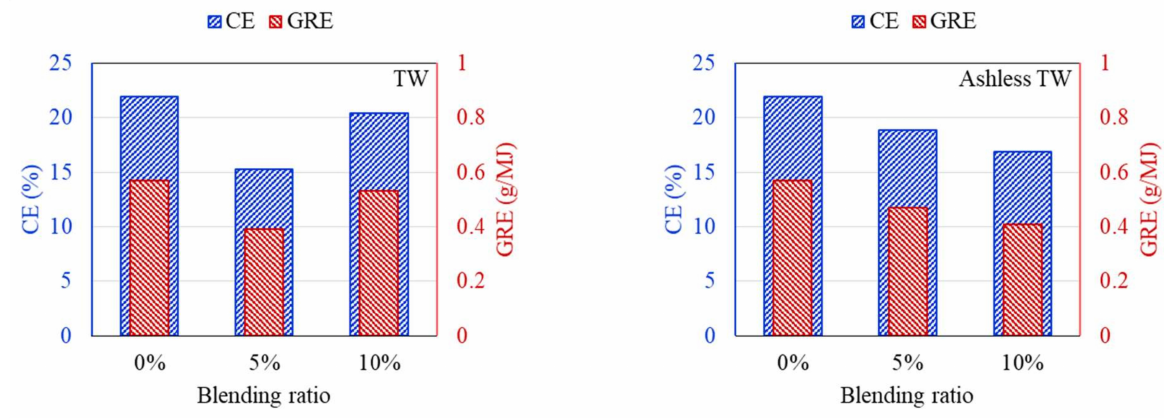
Figure 10. CE and GRE for cofiring different blends of the TW ( left ) and ashless TW ( right ).